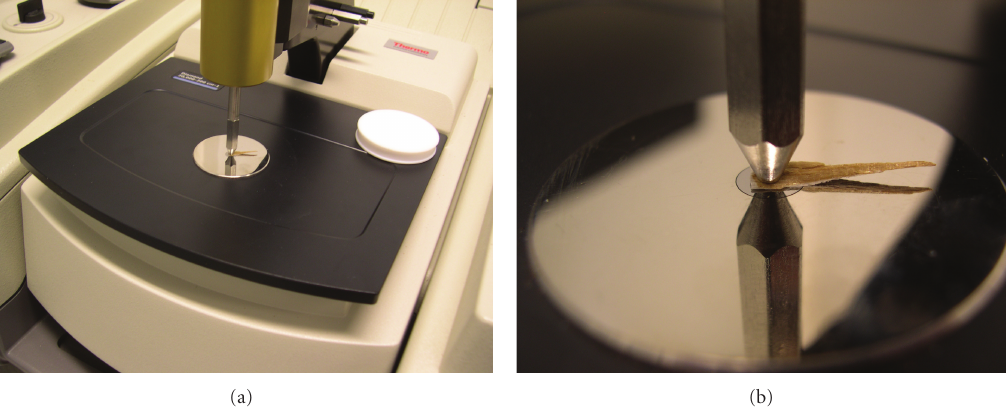
Figure 2: A wood piece from sample A was pressed onto the diamond crystal in the ATR accessory connected to the FTIR spectrometer. In the close-up photo to the right, the lower steel pin is only a reflection of the above steel pin in the polished mirror-like sample plate.